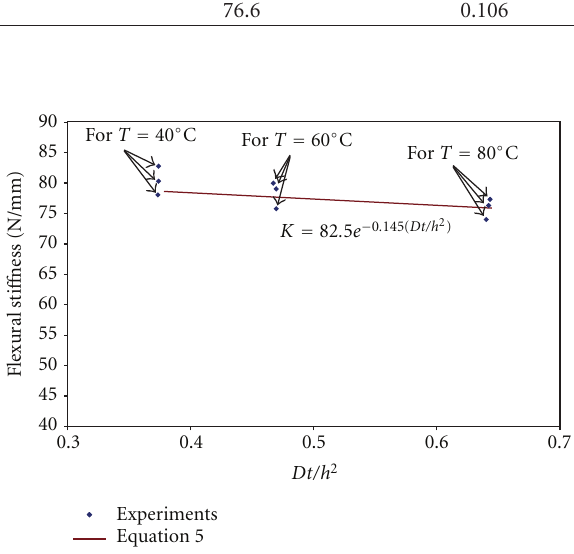
Figure 5: Failure mode observed as a result of the bending tests.